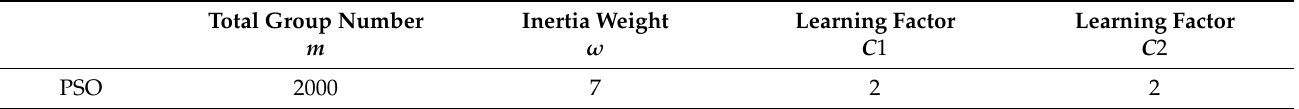
Table 3. Parameters of PSO.